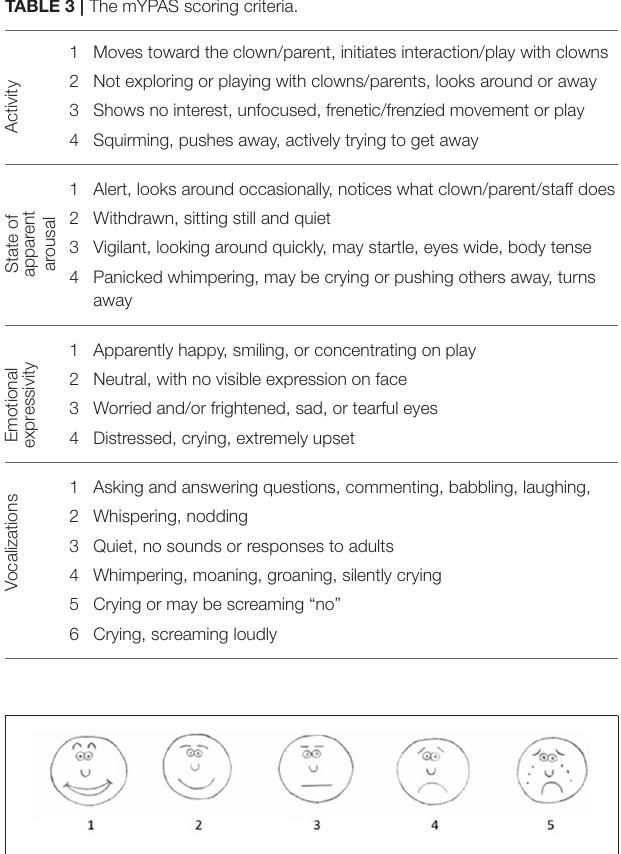
FIGURE 2 | Mood rating